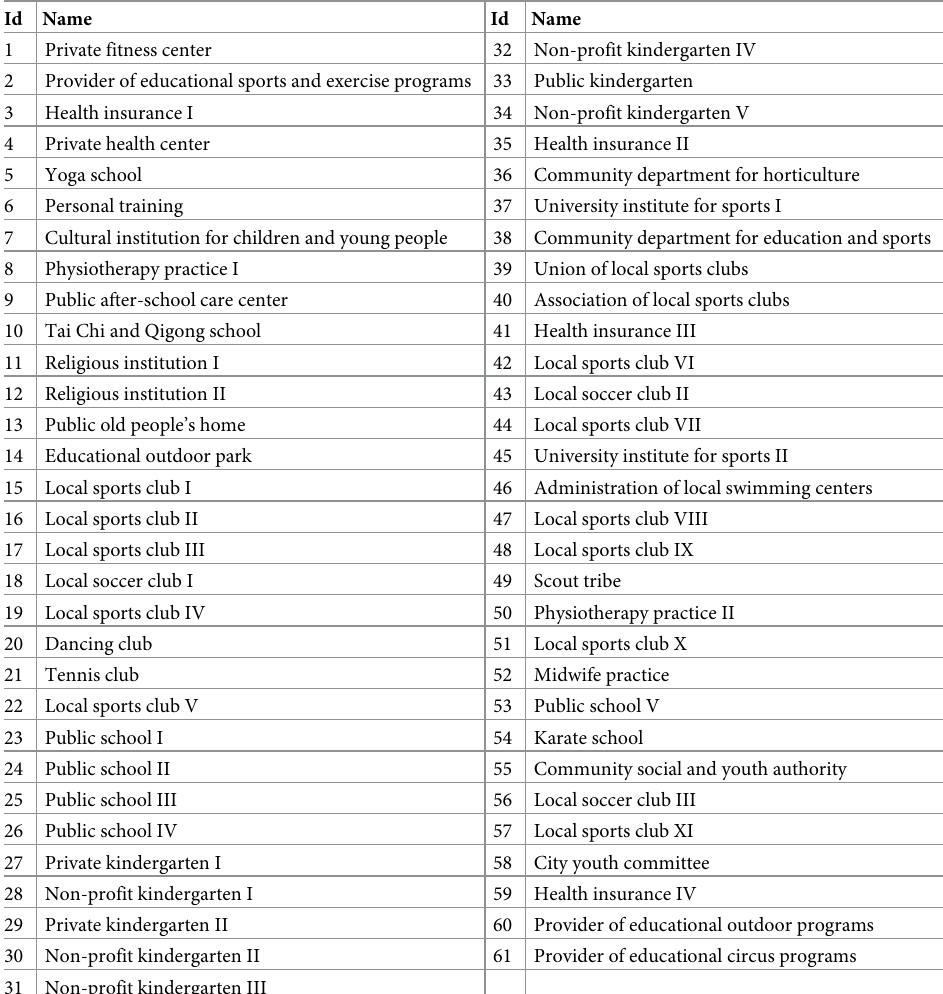
Table 1. List of network